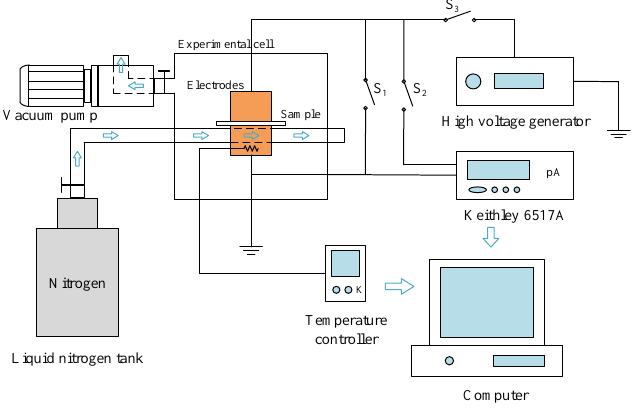
Figure 3. Thermally stimulated current measurement system.